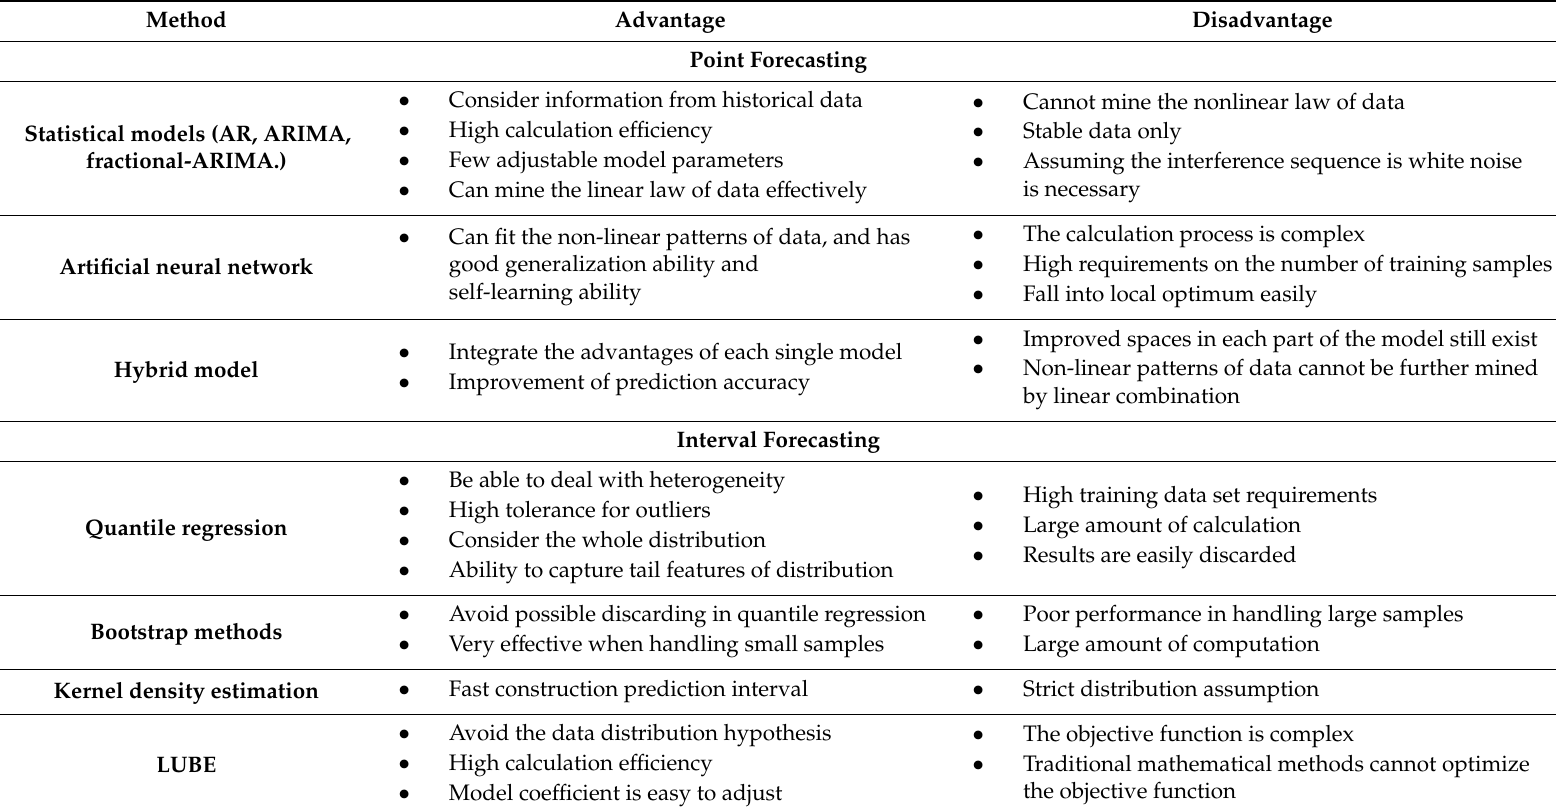
Table 1. Summary of point prediction and interval prediction